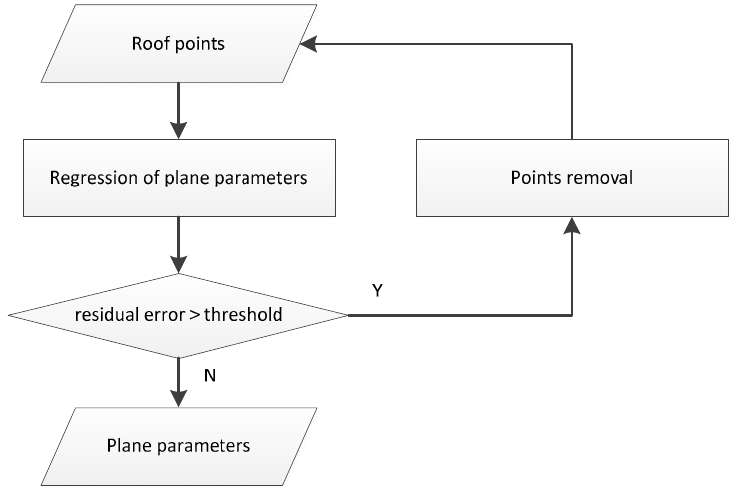
Figure 3. Flowchart of plane parameter regression.